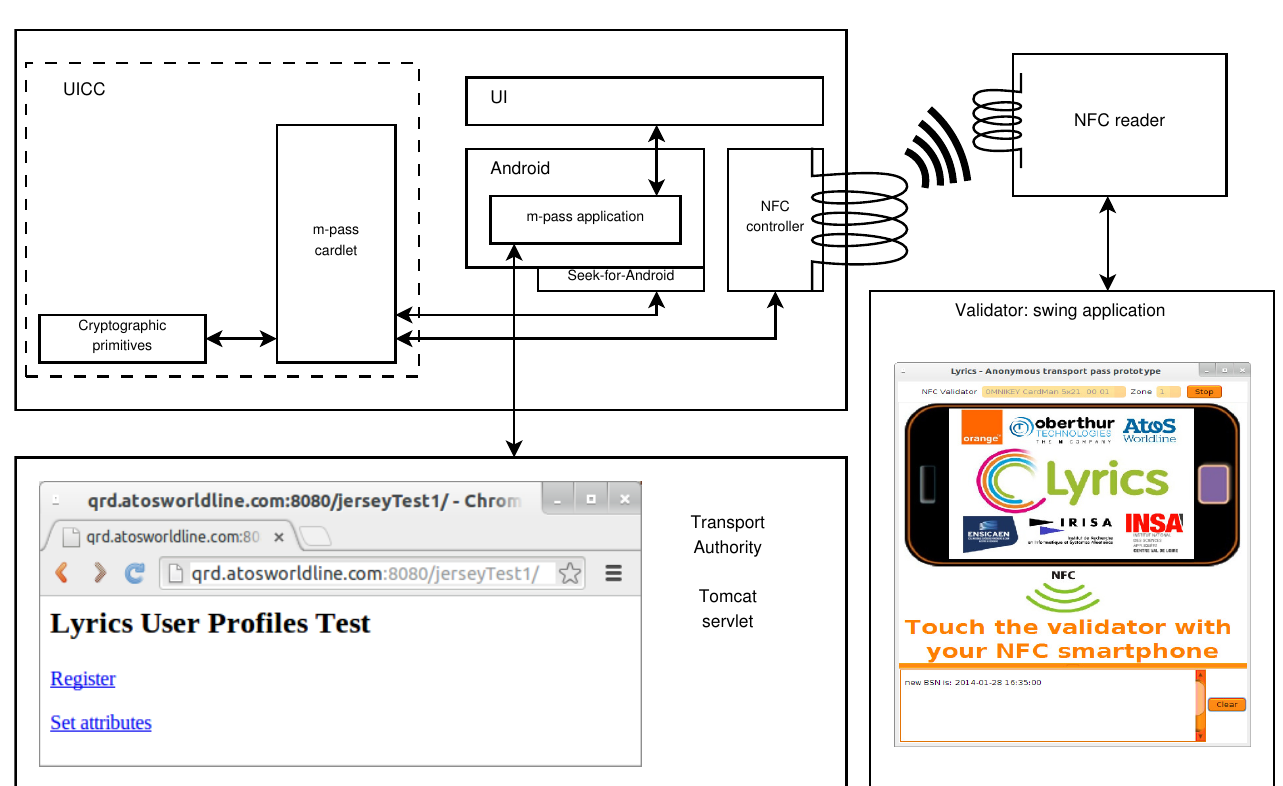
Figure 2. Architecture of the m-pass prototype and validator